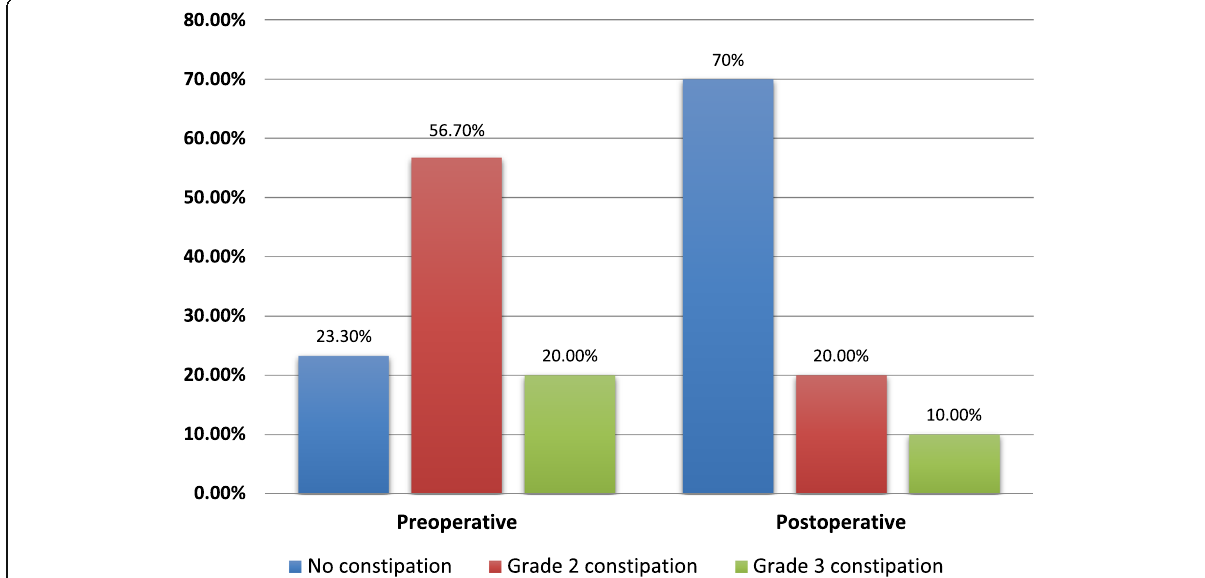
Fig. 2 Bar chart showing improving of constipation grades before and after sagittal anorectoplasties in patients with recto-perineal